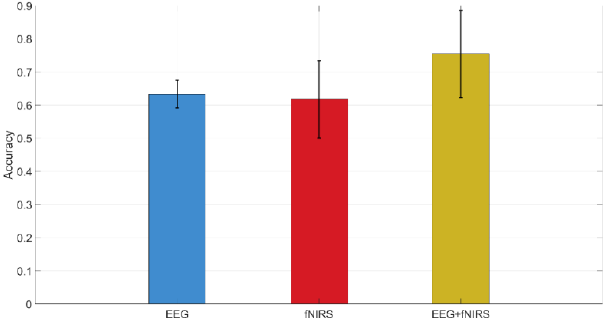
Figure 11. Comparison of the proposed method (EEG + fNIRS) and the ones where only EEG or fNIRS employed for all video-content trials.